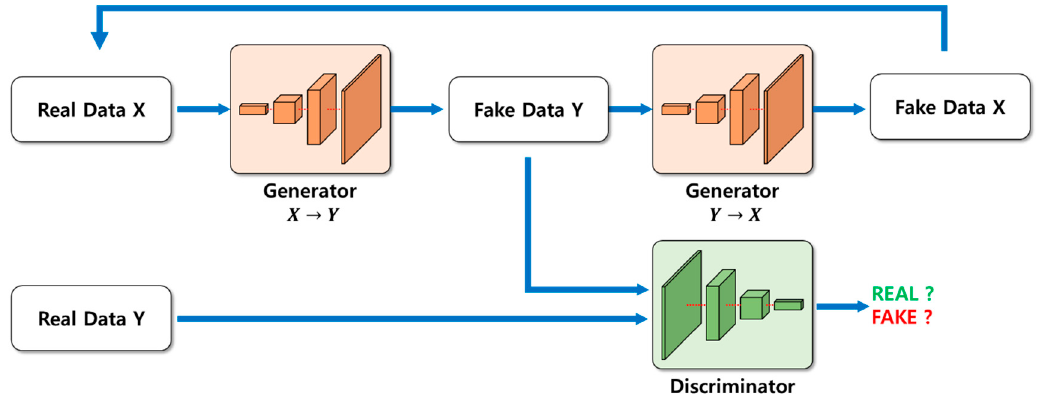
Figure 1. Structure of cycle generative adversarial network (GAN).